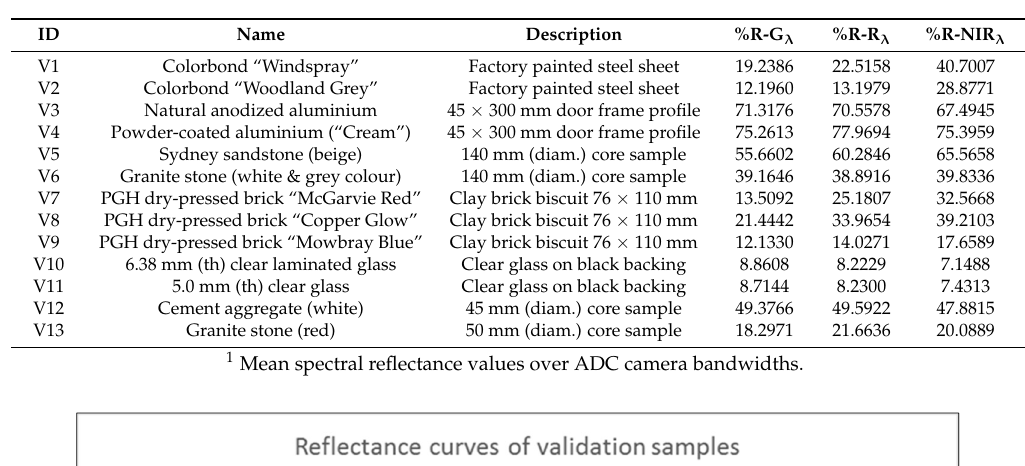
Table 14. Material validation sample ID and measured mean spectral reflectance values 1 .